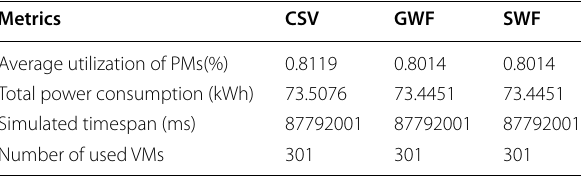
Table 4 Open-source simulators used recently in evaluation